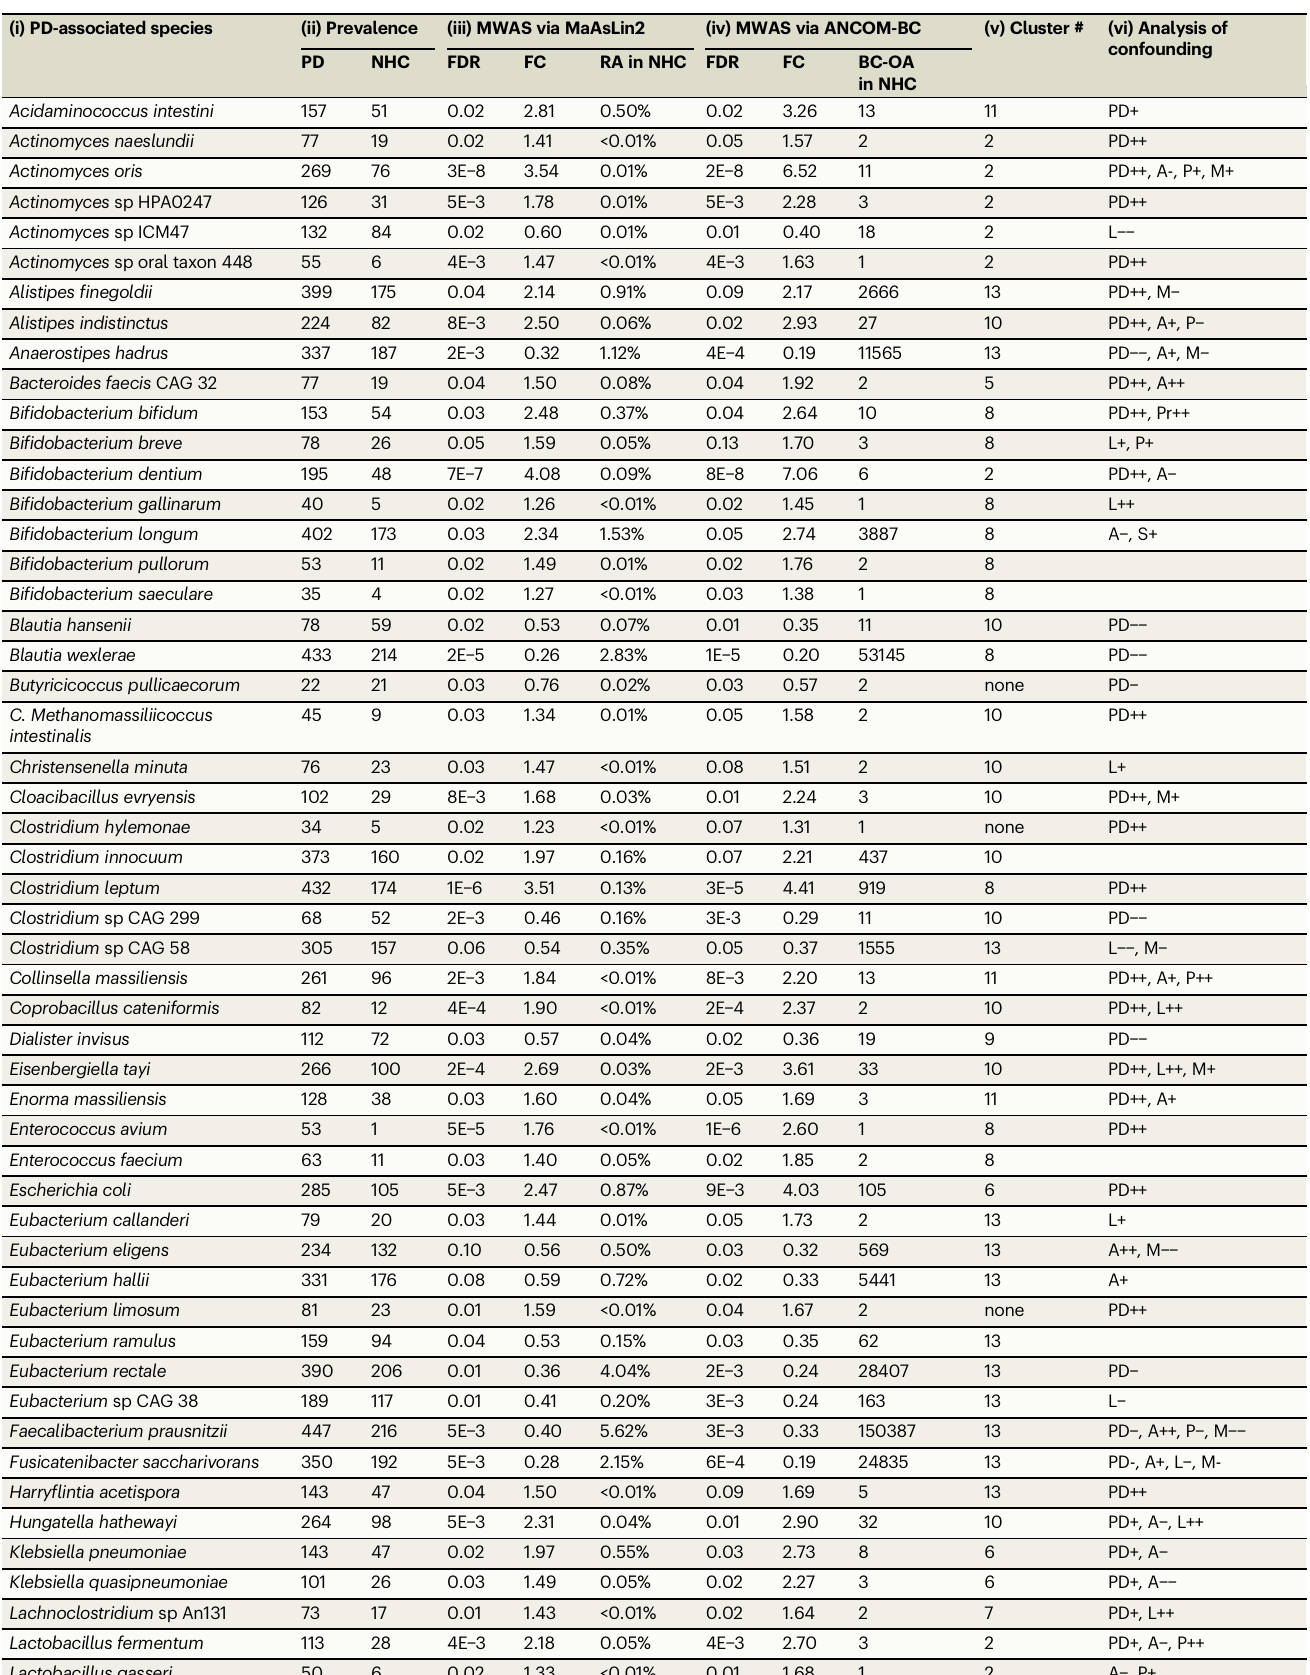
Table 2 | Identi fi cation and characterization of 84 PD-associated